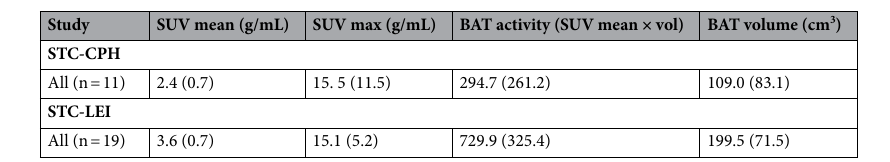
Table 1. BAT activity and volume after short term cold exposure. Data are presented as mean (SD). SUV; g/ mL, BAT volume; cm 3 , BAT activity; SUV mean × BAT volume. STC-CPH; short-term cold, Copenhagen. STC-LEI; short-term cold,